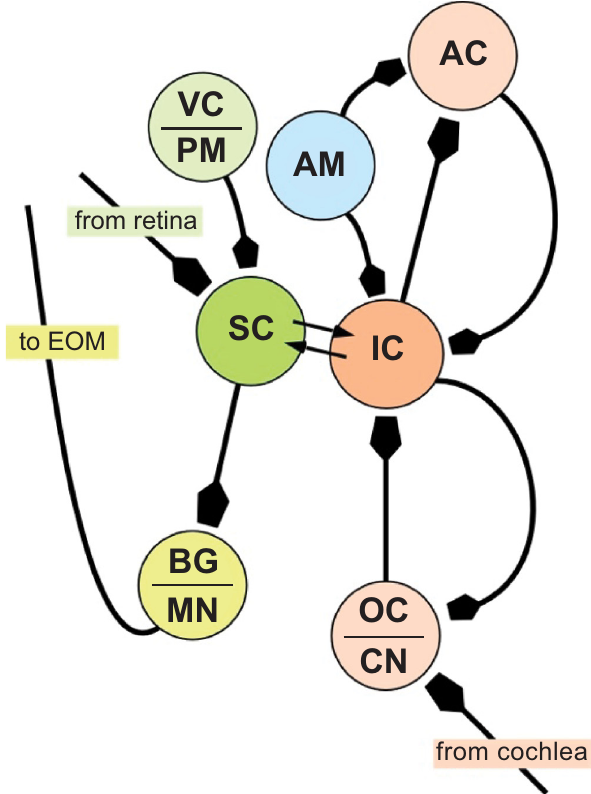
Figure 7. Schematic representing neural circuits creating visual- auditory interactions in the tectum . The superior (SC) and inferior colliculi (IC) receive direct visual (shades of green) and auditory (shades of red) projections, respectively and have reciprocal connections with each other. The IC also receives emotive inputs from the amygdala (AM) either directly 43 or via reward circuitry in the ventral striatum 44 , and has reciprocal connections with the auditory cortex (AC) for cognitive processing 48 . Saccadic eye movements are controlled by outputs from the SC via local burst generators (BG) driving motor neurons innervating extraocular muscles (EOM). The SC receives information from the visual cortex and premotor neurons in the frontal cortex, particularly the frontal eye fields. AC = Auditory Cortex; CN = cochlear nucleus (VIIIn); MN = motor neurons (nuclei of cranial nerves III, IV and VI); PM = Pre-motor Cortex; VC = Visual